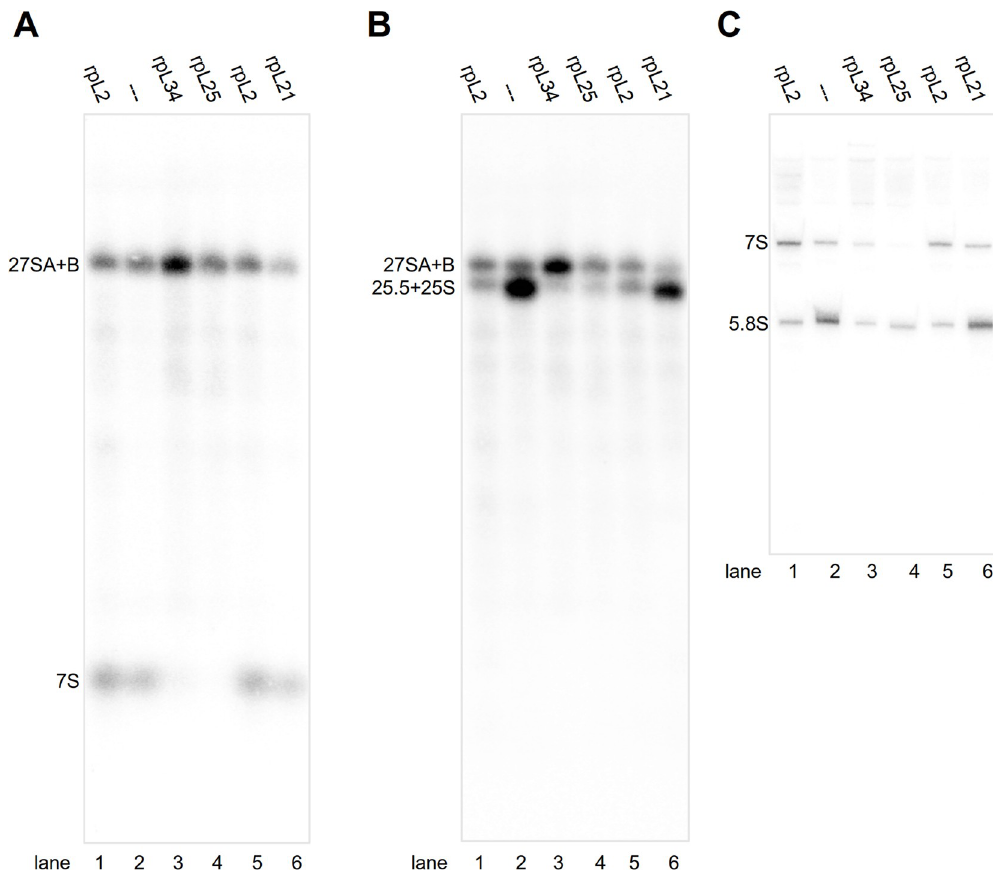
Fig 1. (Pre-)rRNA composition of Nog1-TAP associated particles purified from yeast conditional r-protein expression mutants. Cells of yeast strains in which expression of rpL2 (Y1921), rpL21 (Y1813), rpL25 (Y1816), rpL34 (Y2907) or no r- protein (Y1877, label: “—”) was shut down for four hours were used as starting material for affinity purification of TAP tagged Nog1. (Pre-)rRNA composition of final eluates was analysed by northern blotting with probes O210 (A), O212 (B) and O209 (C) which detect the (pre-)rRNAs indicated on the left. RNA in (A) and (B) was separated by electrophoresis using an agarose gel and in (C) an acrylamide gel.